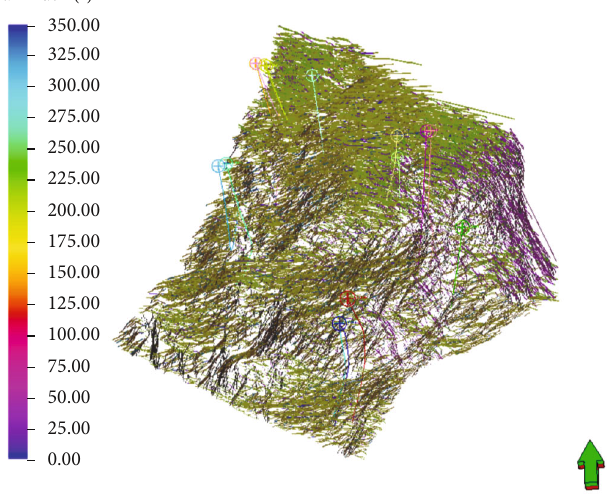
Figure 13: Discrete Fracture Network (DFN) constructed.